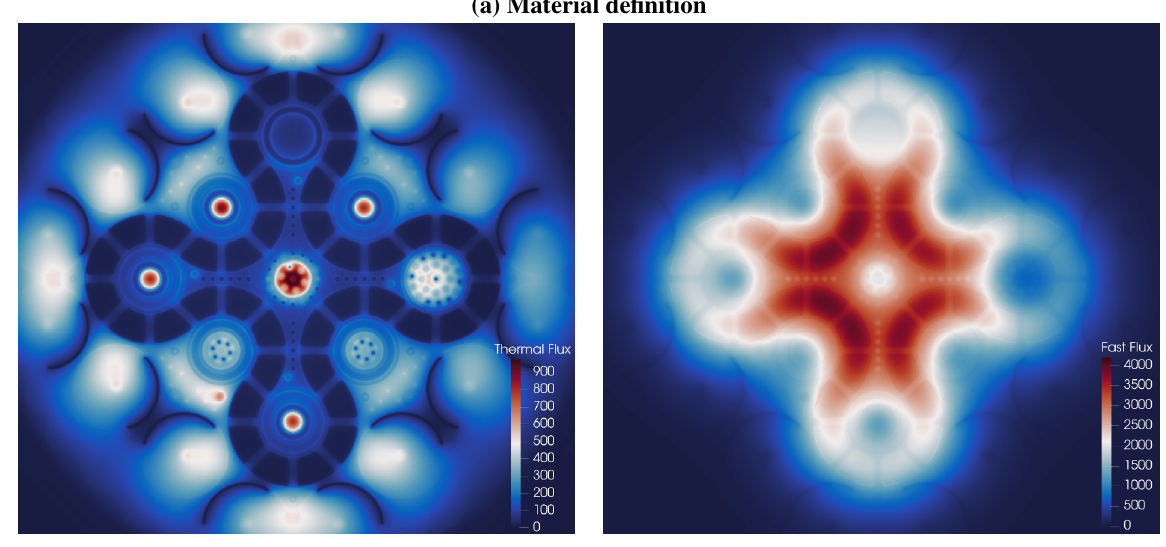
lost in either the Cartesian or DAGMC geometries. New, and presumably small, FSRs are also sometimes not found in the mapping phase and encountered later, during the simulation phase. Methods for integrating these FSRs into other FSRs during simulation could be explored. We also plan to compare the per-bundle power distribution from ARRC for the full ATR model based on previous work